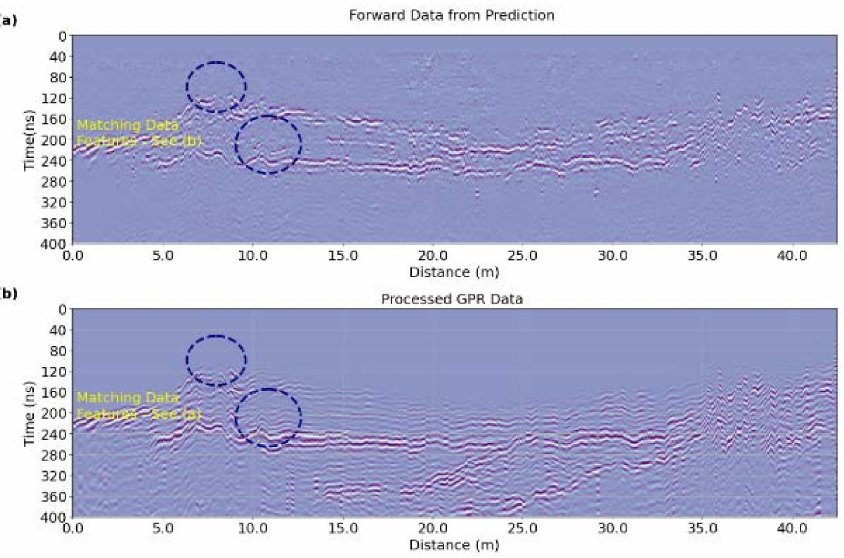
Figure 12. ( a ) The GPR data obtained by performing forward modeling on predicted EM velocity, as shown in Figure 11a. ( b ) Processed field GPR